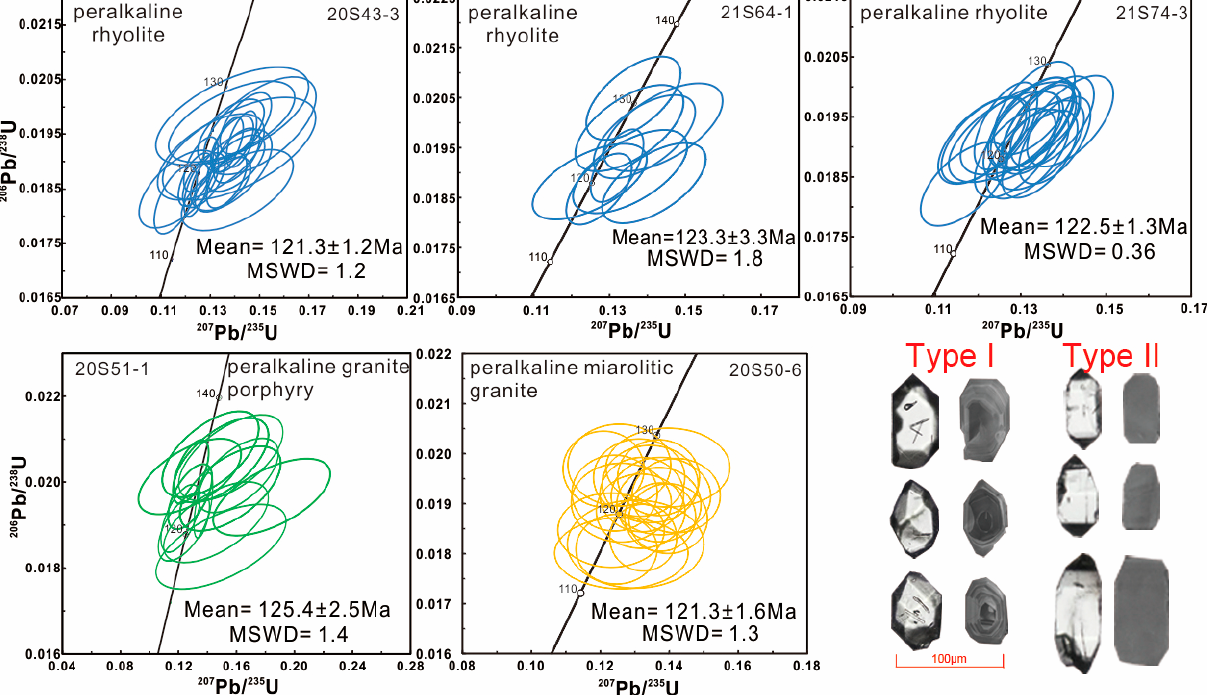
Figure 6. In situ LA-ICP-MS U-Pb Concordia diagrams of zircons from different peralkaline granitic rocks and the CL image of two types of zircons.